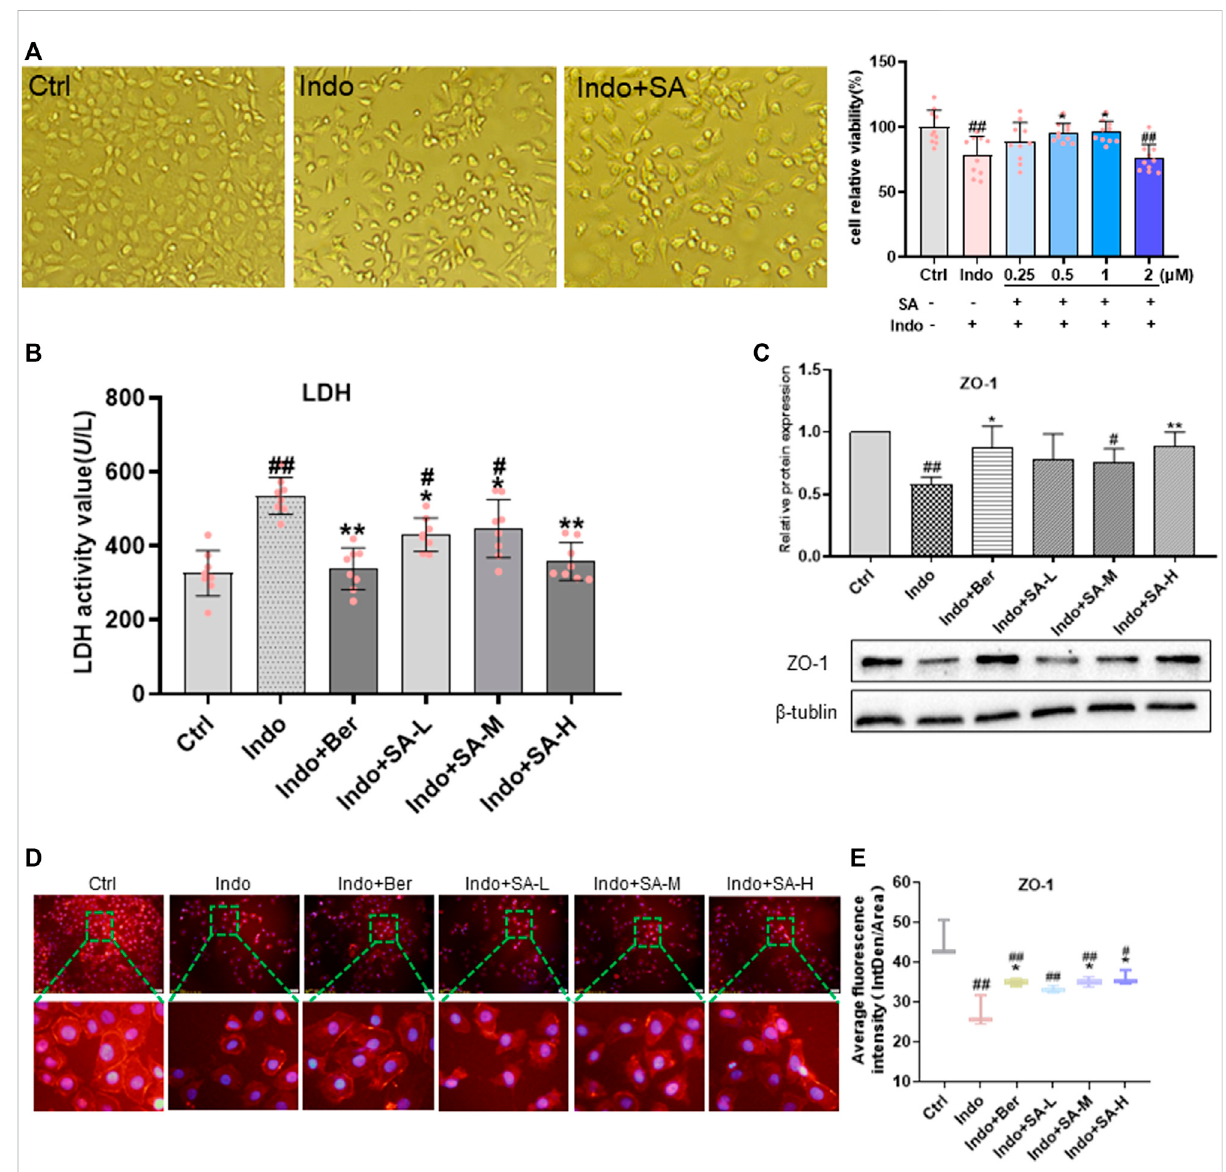
FIGURE 5 SA improved viability, permeability and barrier function of indomethacin-treated IEC-6 cells. IEC-6 cells were treated with indomethacin (Indo, 300 μ mol L − 1 ) and/or sanguinarine (SA, 0.25, 0.5, and 1.0 μ mol L − 1 , SA-L, SA-M and SA-H, respectively) or with berberine (Ber, 30 mmol L − 1 ), and cell viability was measured by CCK8 assay. (A) Viability of IEC-6 cells. Original pictures of IEC-6 cells ( left , magni fi cation at ×200); Protection of SA on indomethacin cytotoxicity ( right ). (B) LDH released from the IEC-6 cells, measured by chemiluminescence ( n = 8). (C) Protein levels of